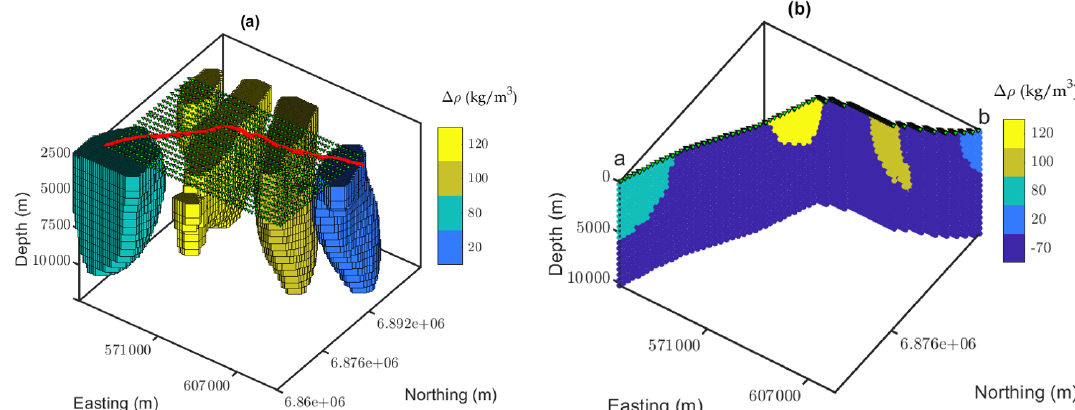
Figure 10. Density contrasts of the adjusted starting model and the interpolated gravity grid configuration (a) model cell centers of the extracted 2D model along the seismic profile (b) .